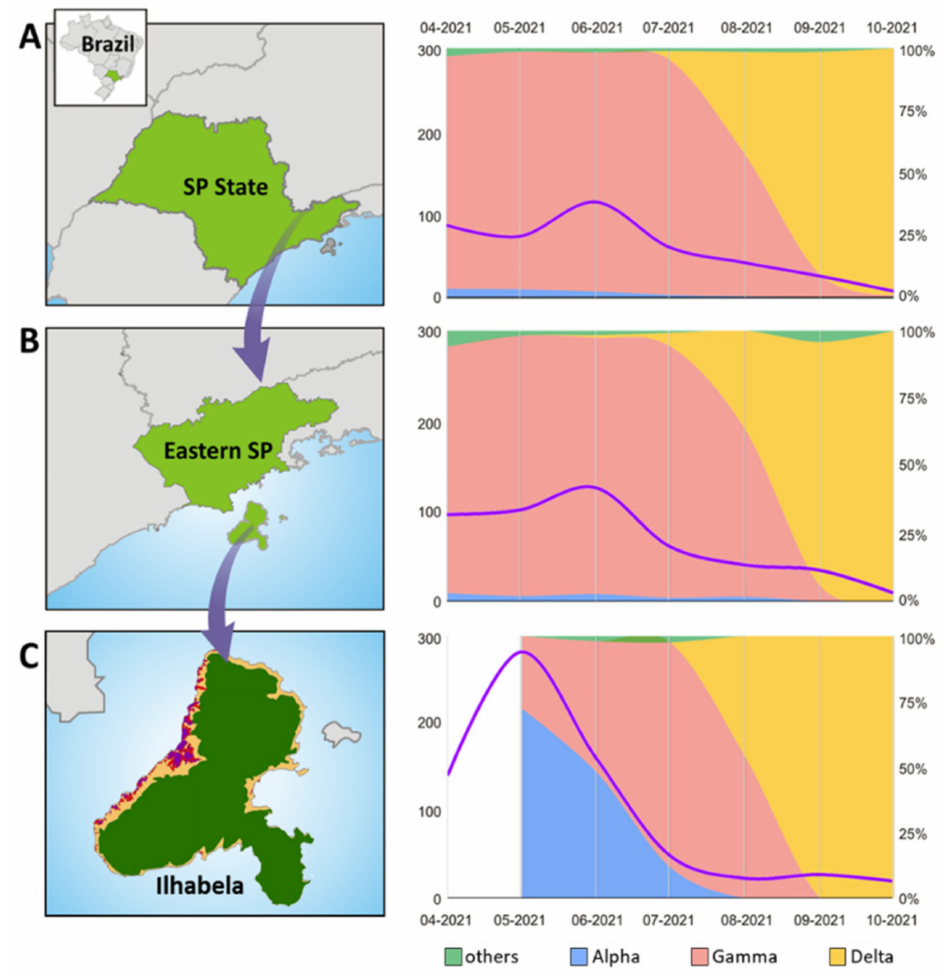
Figure 1. Comparison of the SARS-CoV-2 lineage predominance dynamics and record of new COVID- 19 cases per 10 thousand inhabitants between S ã o Paulo (SP) State ( A ), eastern SP ( B ) and Ilhabela island ( C ) from April to October 2021. The graph’s left axis indicates new cases per 10,000 inhabitants (purple line) and the right axis indicates the proportion of VOCs (Alpha VOC: blue area; Gamma VOC: light pink area; Delta VOC: yellow area; Other lineages: green area). The sampled areas are colored in light green in maps ( A , B ). The Ilhabela map ( C ) shows the protected forest area (dark green) and the unprotected area (yellow) with its denser urban spots (purple) (density map adapted from